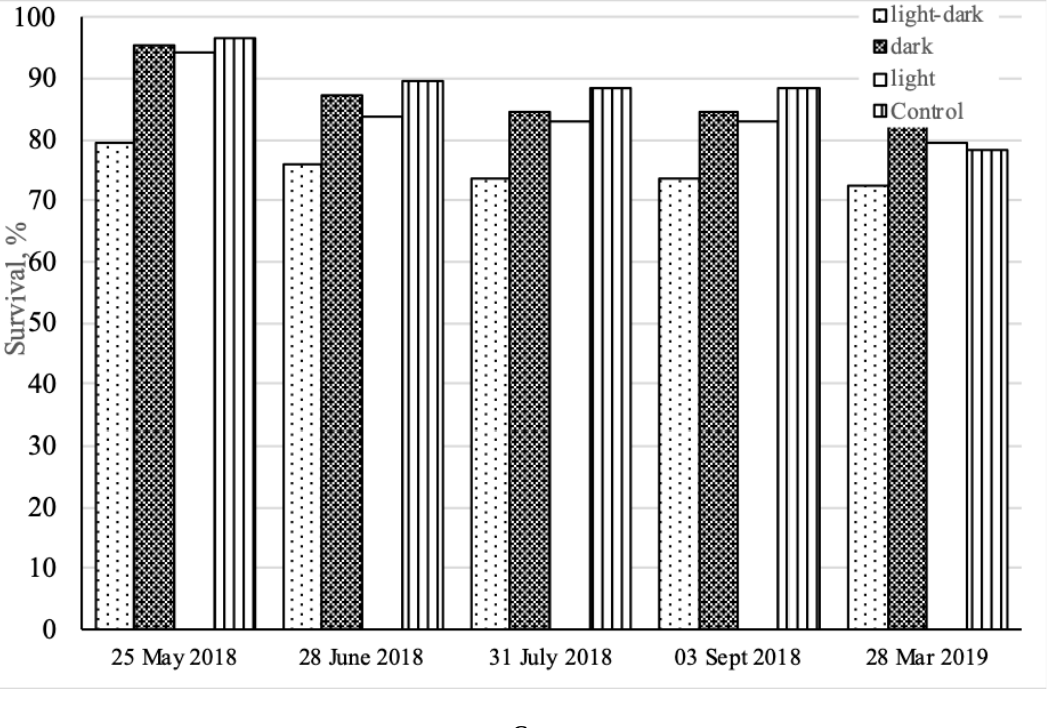
Figure 2. Dynamics in Pinus sylvestris L. seedlings height ( A ), RCD ( B ), and survival ( C ), as measured in the first juvenile stage.